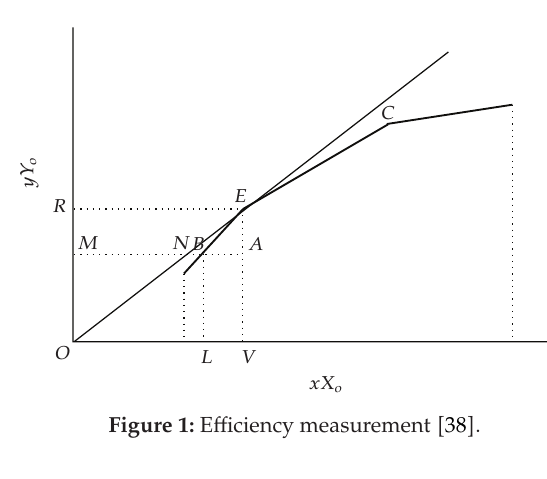
Figure 1: E ffi ciency measurement (cid:5) 38 (cid:6)